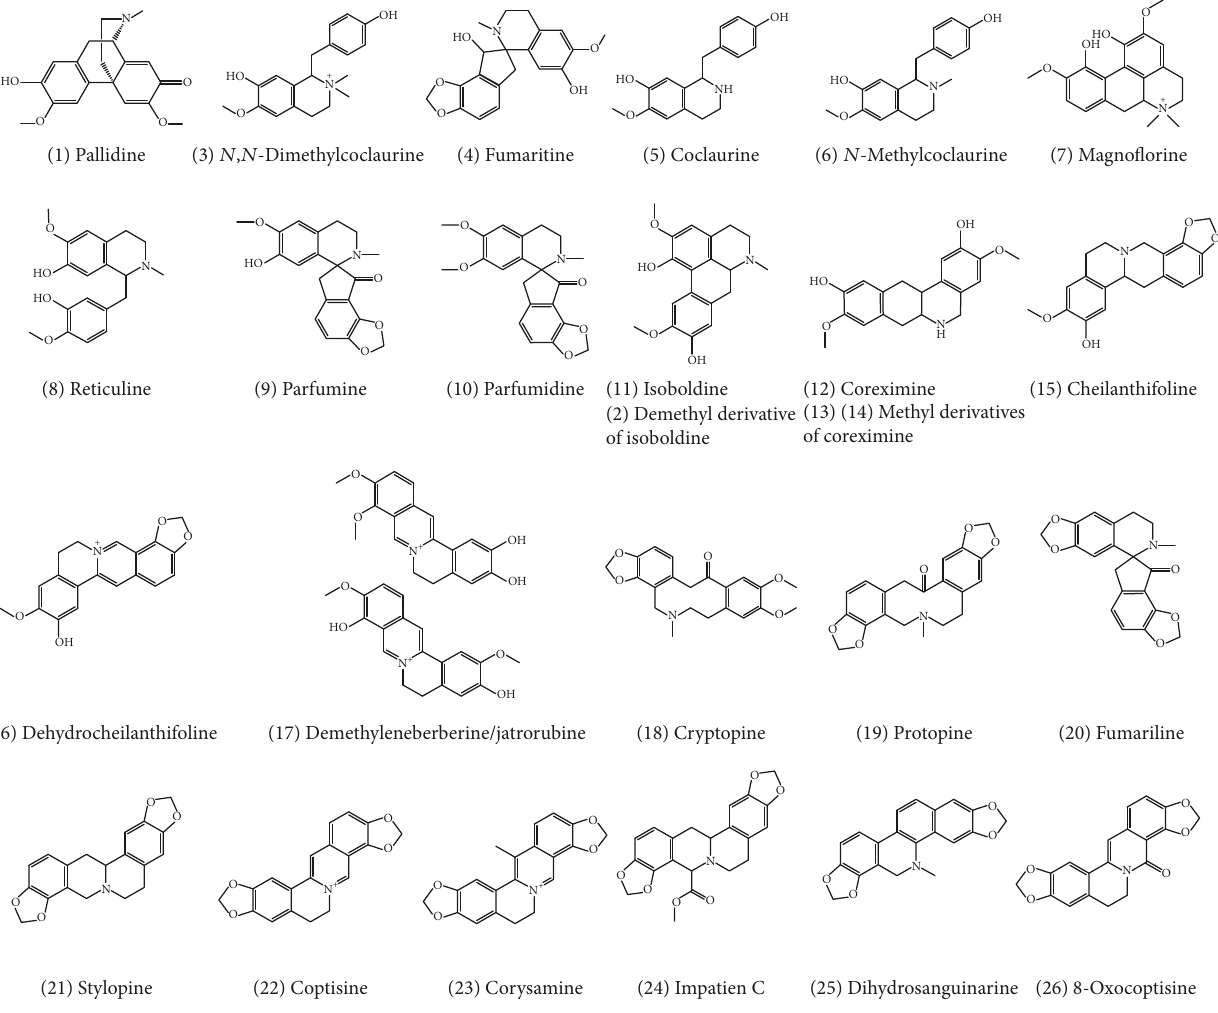
Figure 3: Chemical structures of the alkaloids present in F. capreolata extract and characterized by the QTOF platforms. Compounds are numbered according to Table